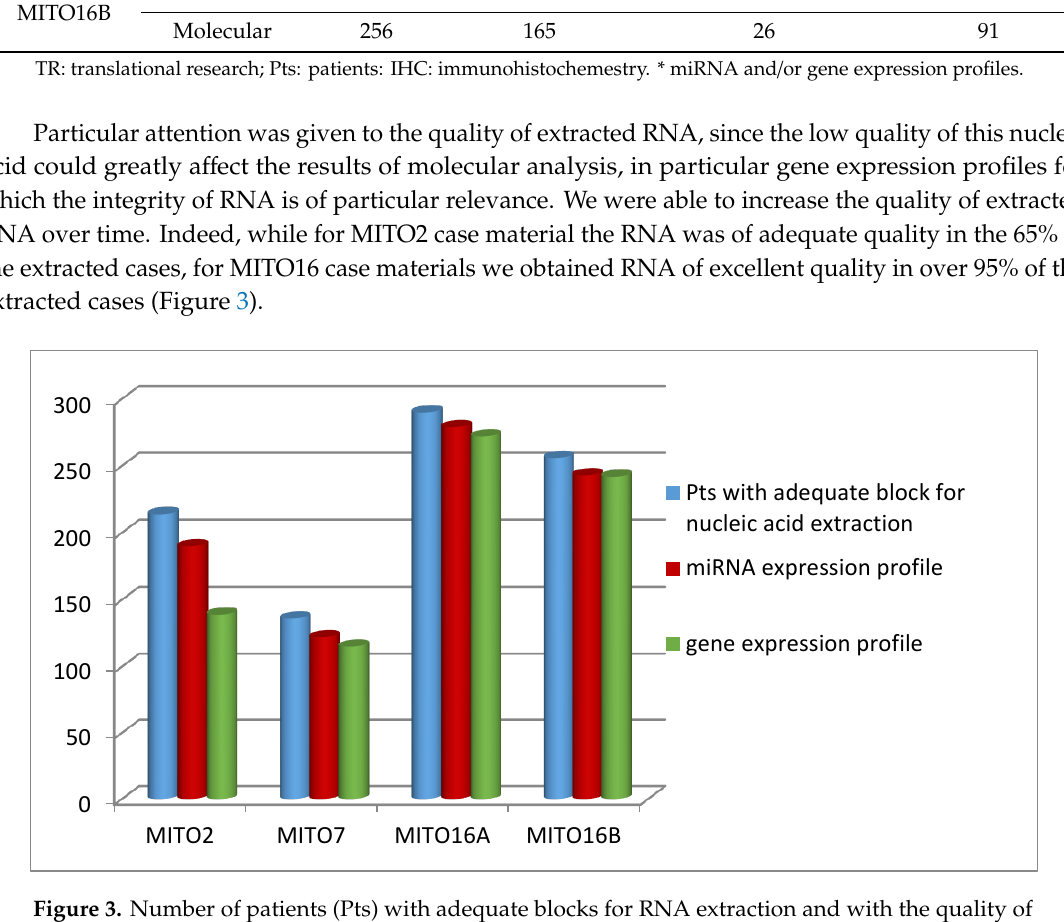
Figure 3. Number of patients (Pts) with adequate blocks for RNA extraction and with the quality of RNA adequate for the indicated analyses.